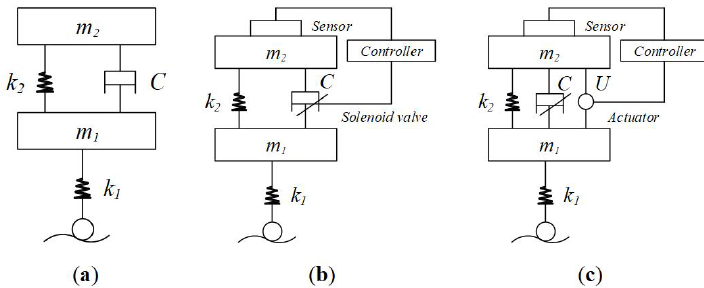
Figure 4. Structure of three types of suspension. (a) Passive suspension. (b) Semi-active suspension. (c) Active